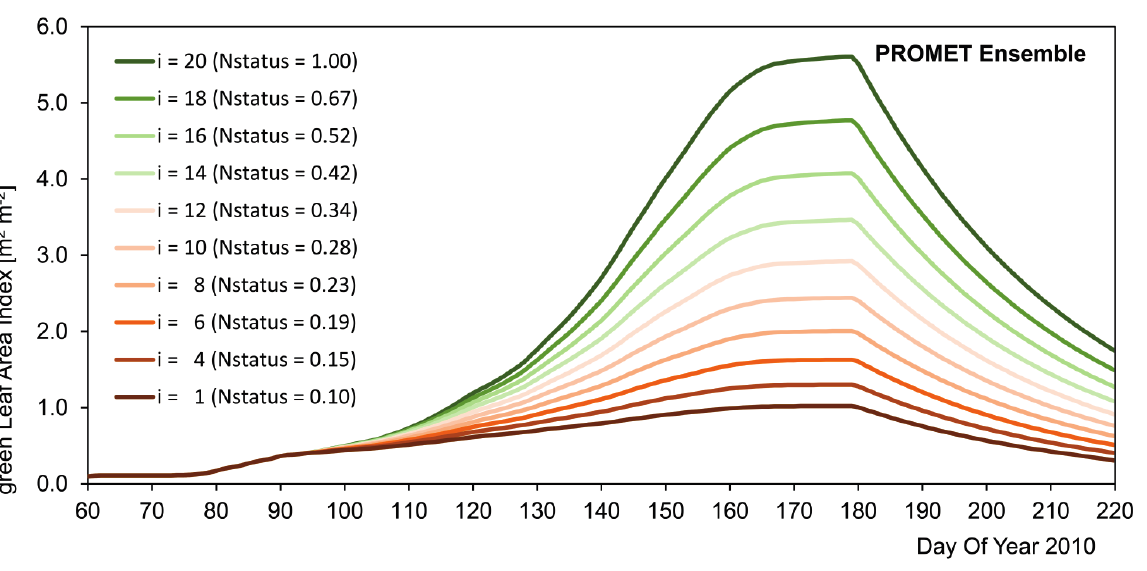
Figure 2. PROMET ensemble consisting of 20 scenarios (only 10 selected for display). Seasonal development of greenLAI is shown for an exemplary location within a winter wheat field in northern Germany (year 2010). Each scenario is based on different assumptions on nitrogen supply ( N status